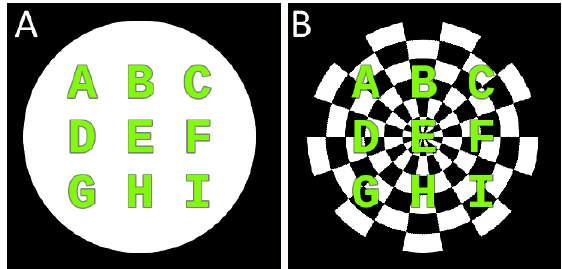
Figure 1. Stimulation circles used in the study, both were 270 pixels in diameter with the text content located inside the center. A white circle ( A ) and a circled checker-board consisting of 20° arcs and six layers ( B